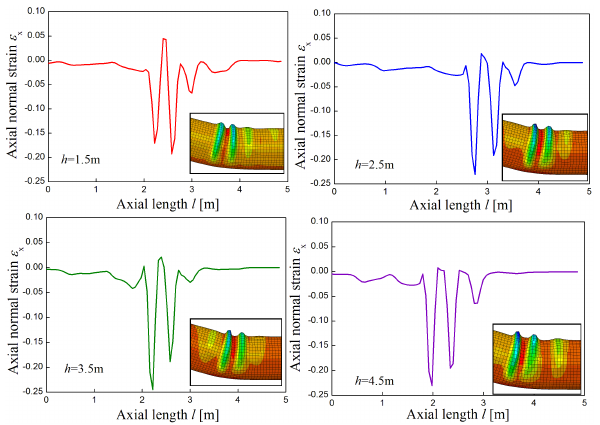
Figure 14. Variations of axial strain at the compression side of the buckling area under different buried depths.